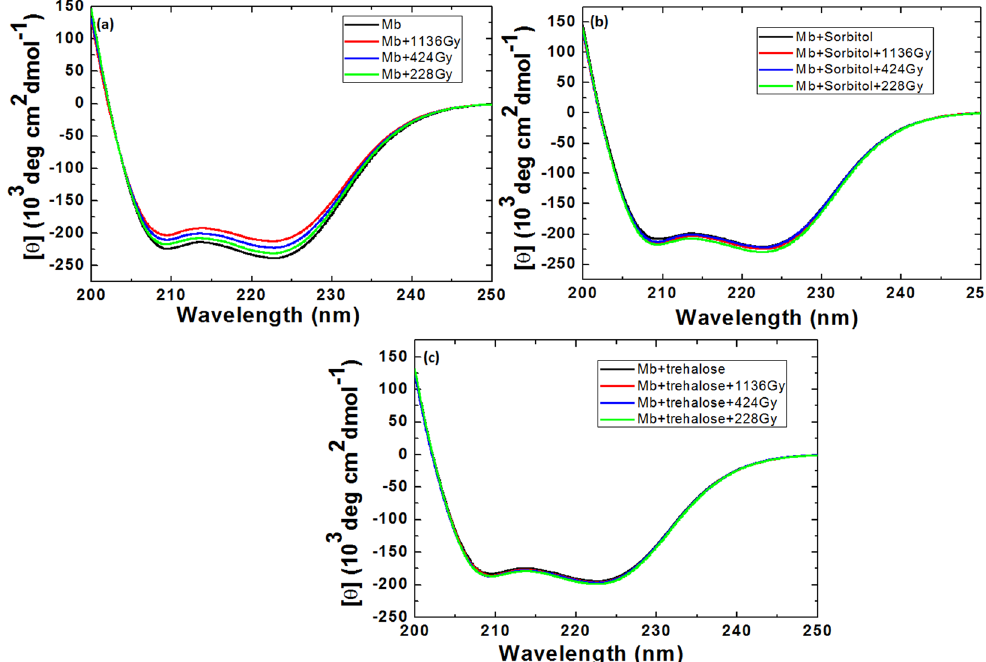
Figure 3. Analysis of Myoglobin secondary structure change using CD spectroscopy after treatment with different gamma rays absorbed dose such as 1136, 424 and 228 Gy ( a ) control Myoglobin, ( b ) Myoglobin + sorbitol and ( c ) + trehalose.